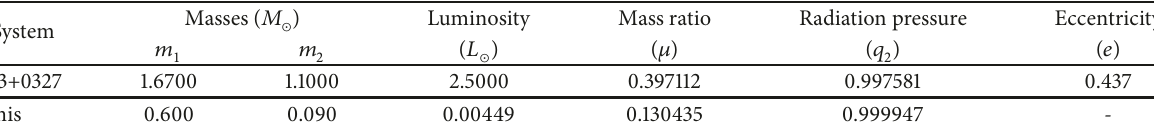
Table 1: Relevant numerical data.